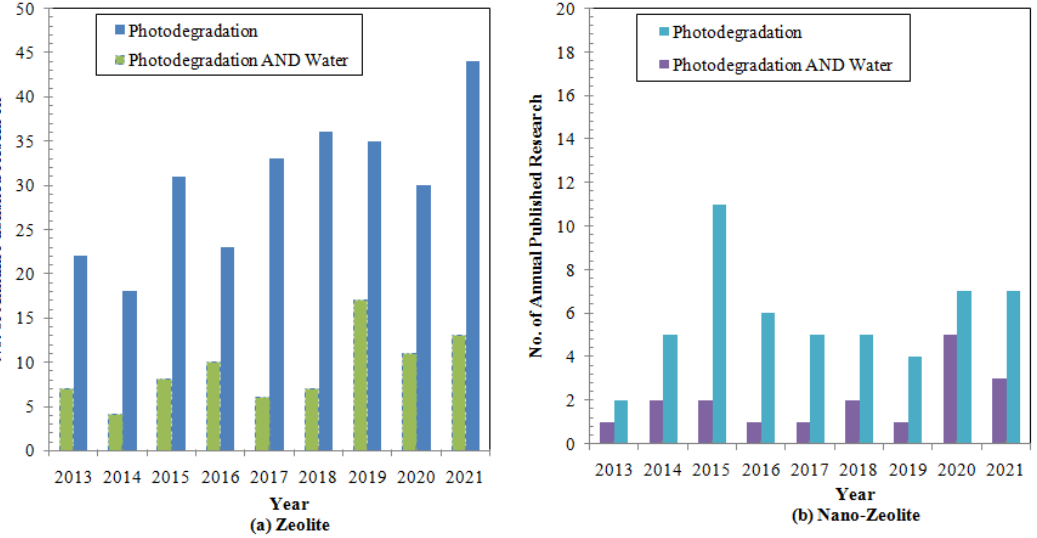
Figure 7. Annual distribution of the research that addressed the application of ( a ) zeolites; ( b ) nano-zeolites in photo-degradation and photo-degradation in water.